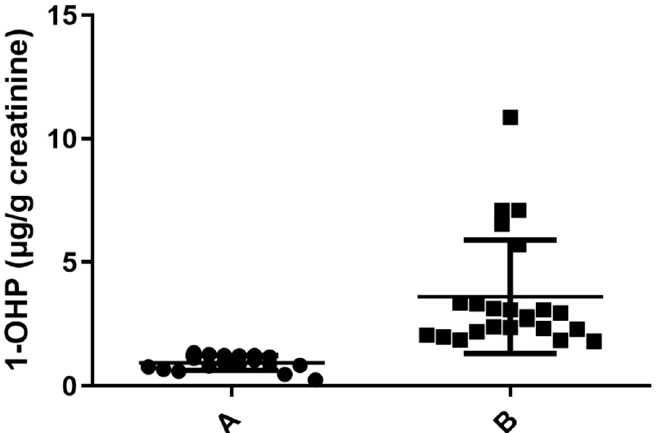
Figure 1. Determination of 1 -OHP in µ g/g creatinine in urine samples exposed to PAHs. Samples with urine concentration of 1-OHP ≤ 1.46 µ g/g creatinine ( n = 18) A. Samples with concentration of 1-OHP > 1.46 µ g/g creatinine ( n = 23), ( p = 0.0001) B.